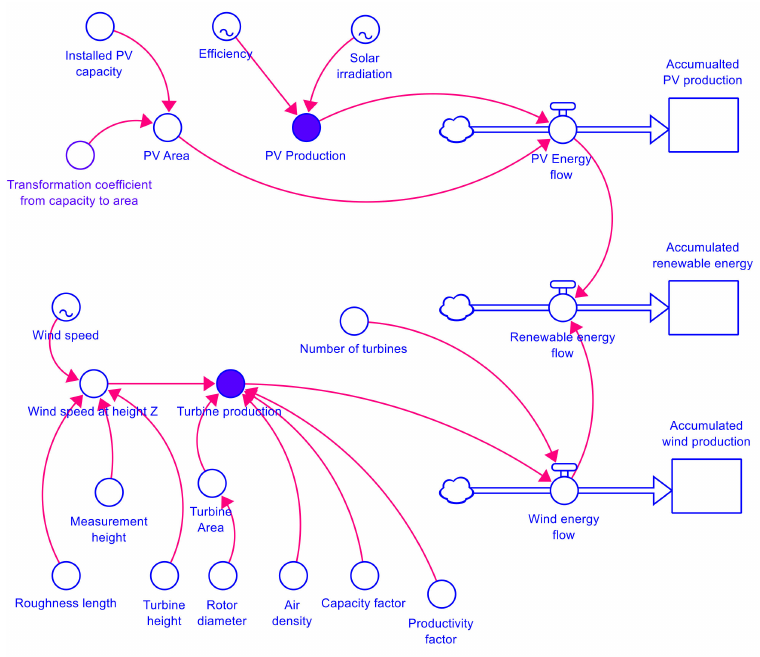
Figure 6. RES power production